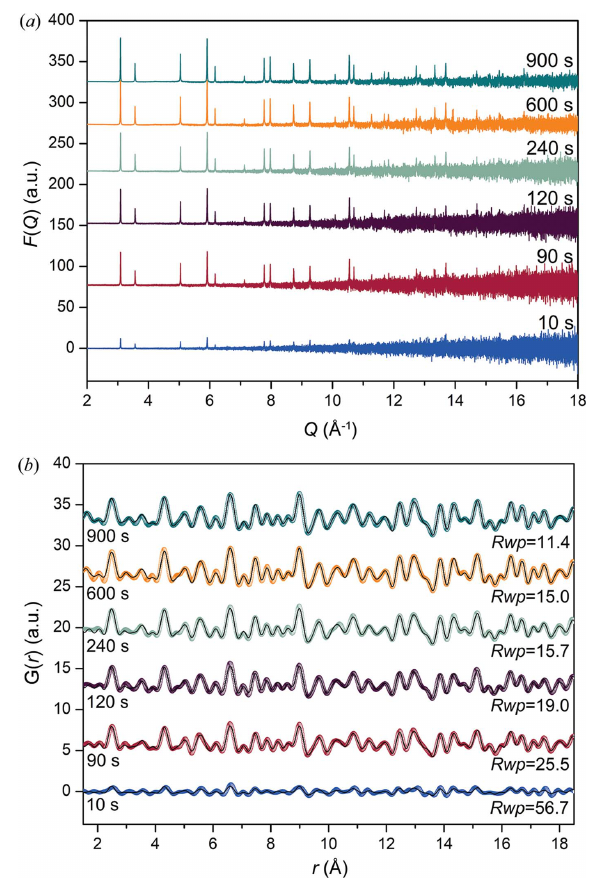
Figure 4 Data for the Ni particles showing ( a ) noise in F ( Q ) at higher Q decreases as the counting time increases, and ( b ) how the increase in statistical error manifests in G ( r ). For ( b ), the dotted plot is the measured data and the line (black) shows the refined